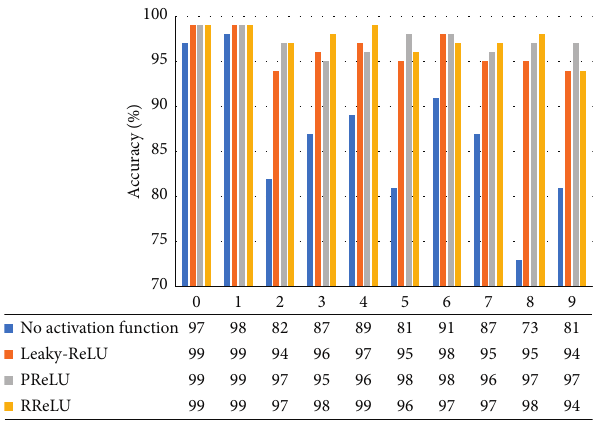
Figure 10: Recognition accuracy of MNIST dataset by N-D 2 NN.